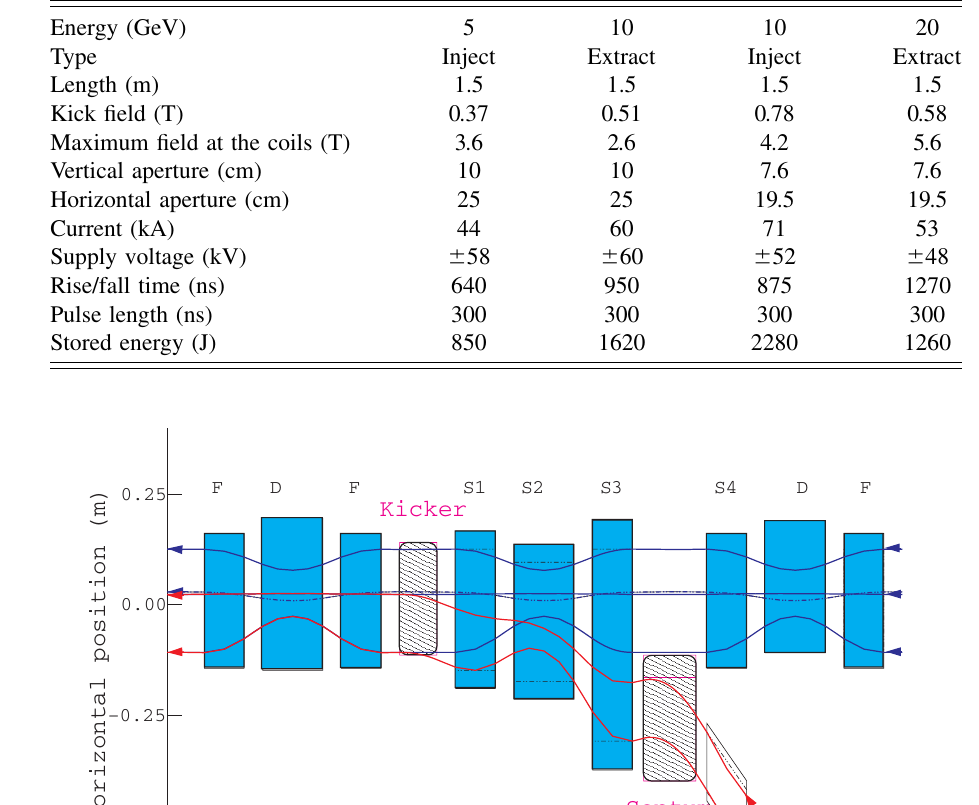
TABLE VII. Parameters for FFAG injection and extracting kickers.